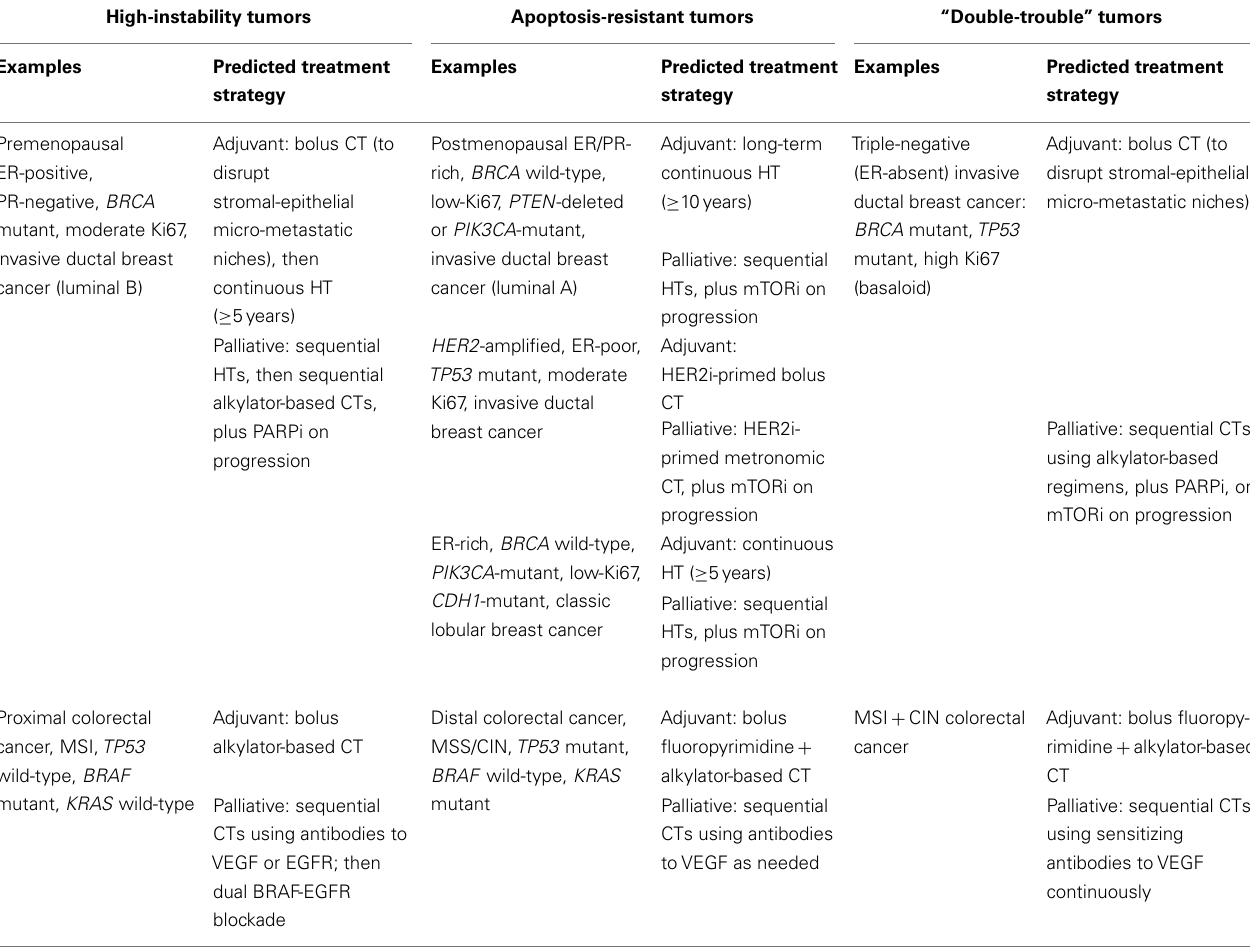
Table 2 | Examples of tumor types differing in extent of caretaker/gatekeeper suppressor gene dysfunction, together with suggested therapeutic